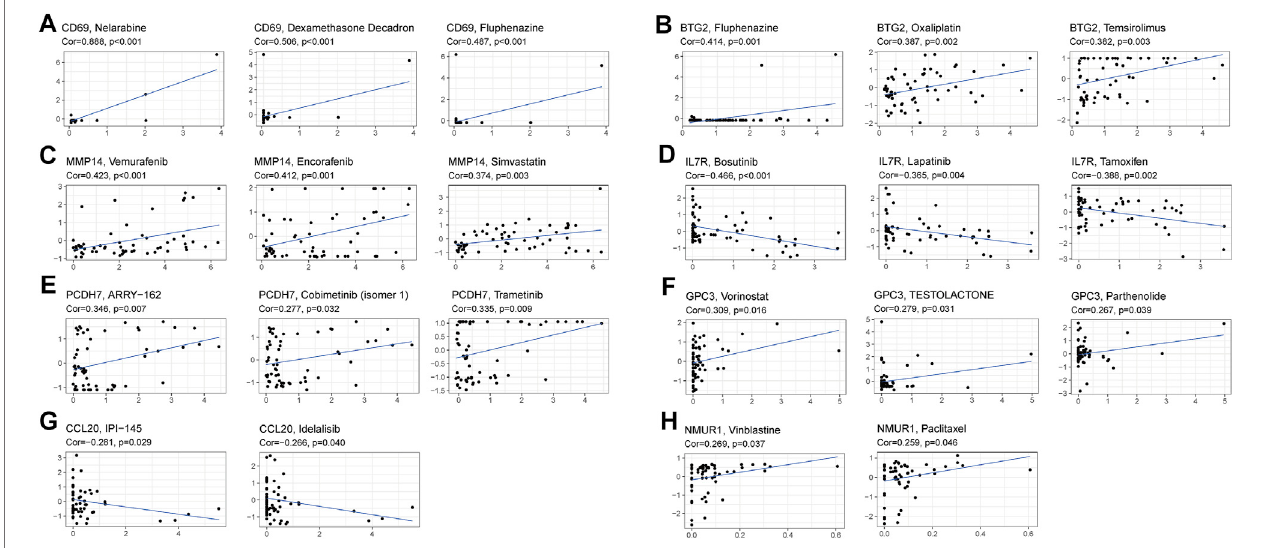
FIGURE 9 | Scatter plot of relationship between prognostic gene expression and drug sensitivity. (A) CD69. (B) BTG2. (C) MMP14. (D) IL7R. (E) PCDH7. (F) GPC3. (G) CCL20. (H) NMUR1.